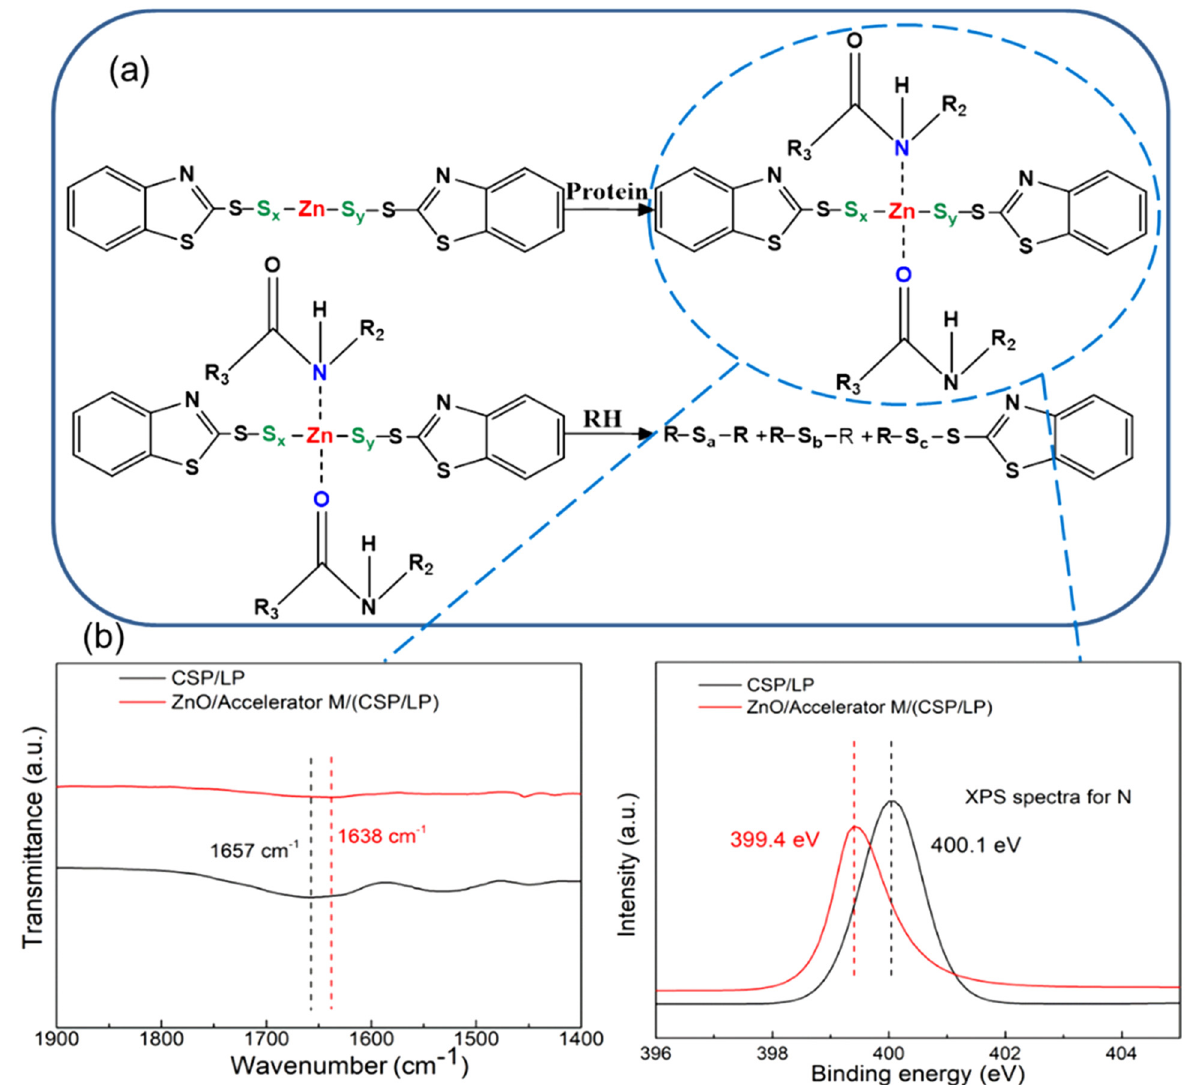
Figure 3: ( a ) The mechanism of promoting sul fi dation by adding zinc oxide and CSP/LP; ( b ) FTIR and XPS of CSP/LP and ZnO/accelerator M/protein